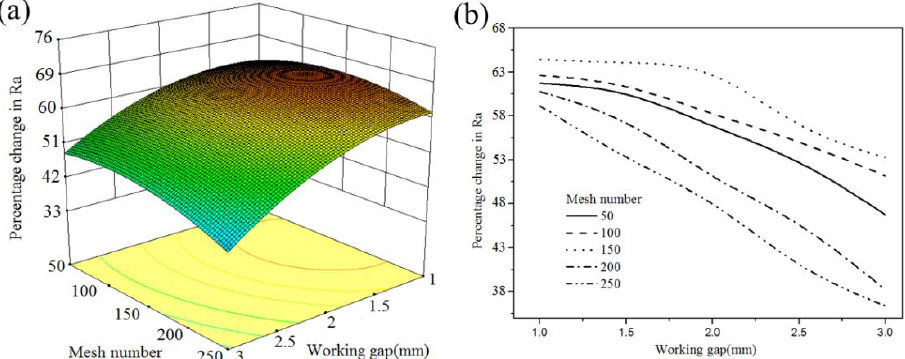
Figure 11. Interaction effect between the working gap and mesh number (feed rate: 1 mm/min; rotational speed: 1500): ( a ) 3D curved surface; ( b ) 2D graph.